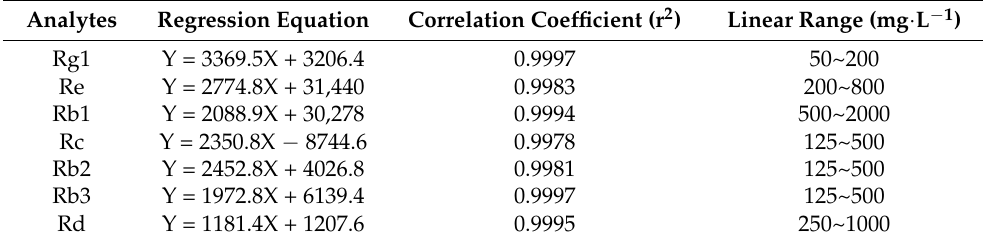
Table 2. Regression equation for seven